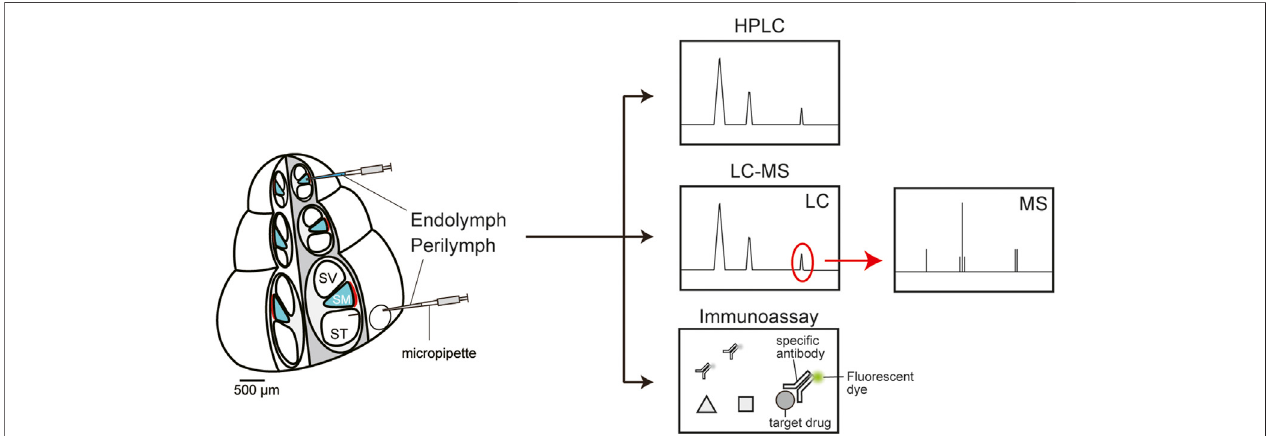
FIGURE2| Invitro chemicalanalysesoftheperilymphandendolymph.High-performanceliquidchromatography(HPLC,toppanel)canquicklyseparateamixture of molecules from a sample according to their chemical properties such as size and hydrophobicity. Each reagent is sequentially detected as a peak and quanti fi ed by calculating the peak area. Liquid chromatography coupled with mass spectrometry (LC-MS, middle panel) is a highly sensitive and selective analytical method for molecularidenti fi cationandquanti fi cation.First,mixturesofmultiplecompoundsareseparatedbyliquidchromatography(LC).Thereafter,thetargetdrug(s)canbe extracted and quanti fi ed via mass spectrometry (MS). An immunoassay can analyze target molecules using a speci fi c antibody conjugated with a fl uorescent dye (bottom panel) . This method is characterized by relatively high quantitativity, easy handling, and time- and